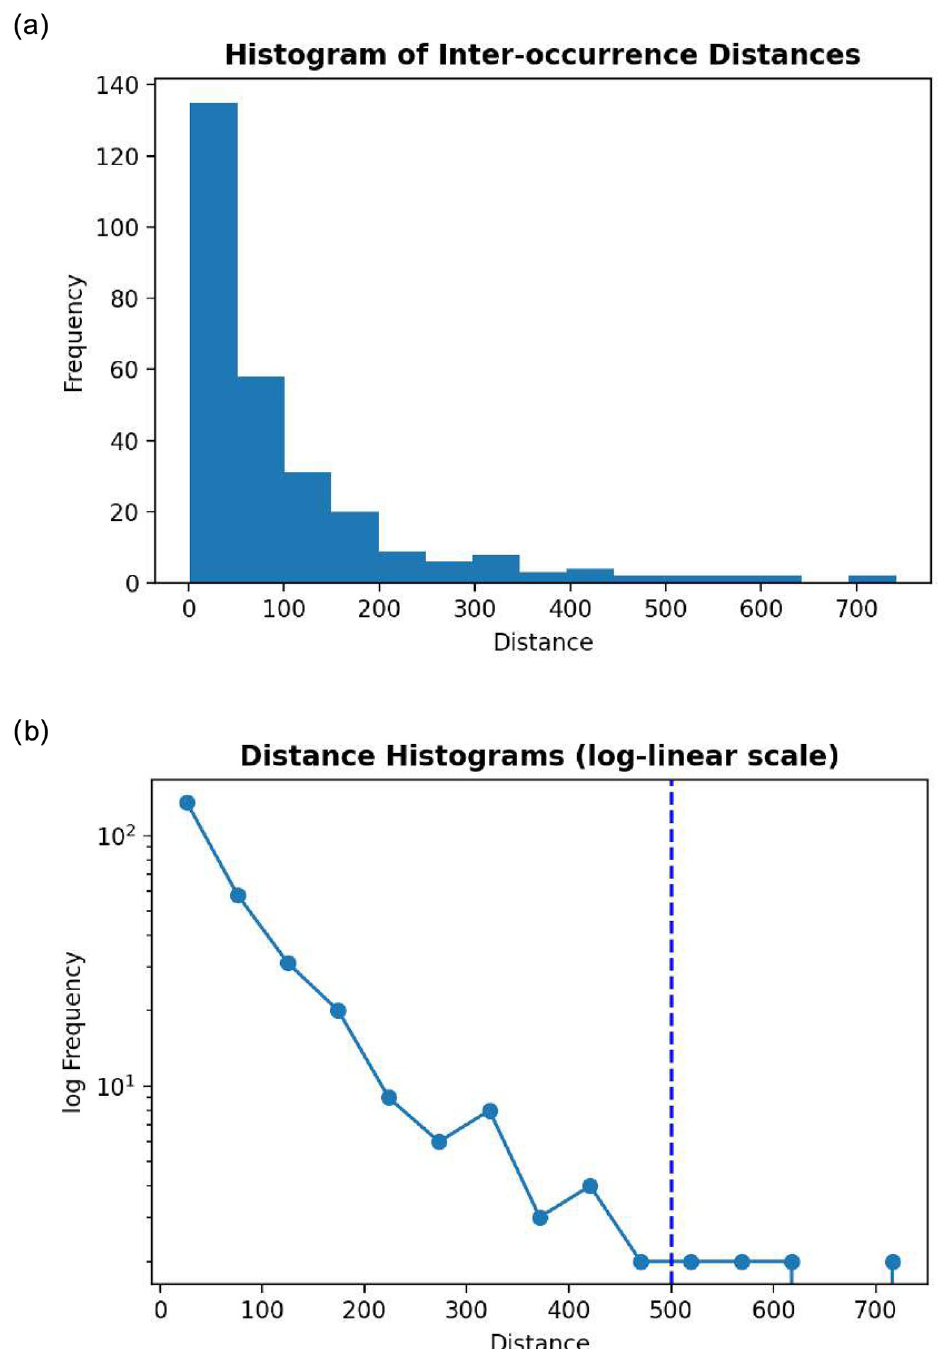
Fig 12. Interoccurrence distance histograms. a) Linear, b) Log-linear.